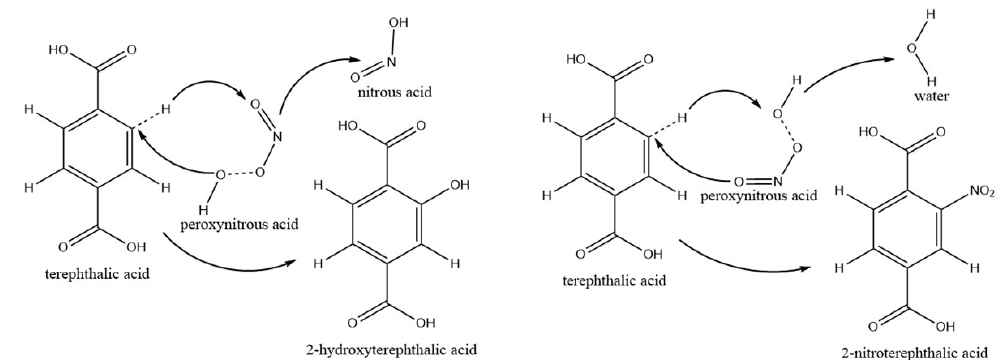
Figure 7. Pathways for the oxidation of terephthalic acid (TA) by ONOOH. The homolysis of ONOOH into OH and NO 2 radicals leads to the oxidation of TA into 2-hydroxyterephthalic acid or 2-nitrogrephthalic acid.